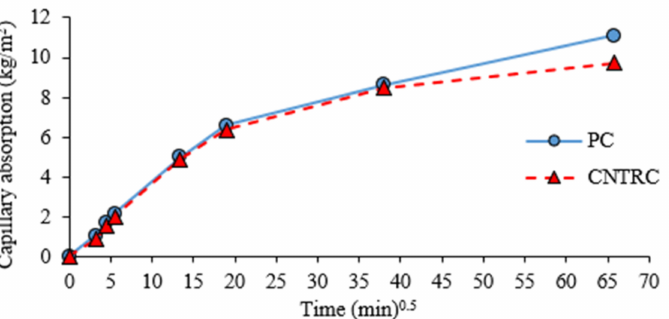
Figure 3. Capillary absorption over time for uncracked concrete specimens. Table 5. Capillary absorption coefficients and 72 h water abortion for concrete under different cracking conditions.